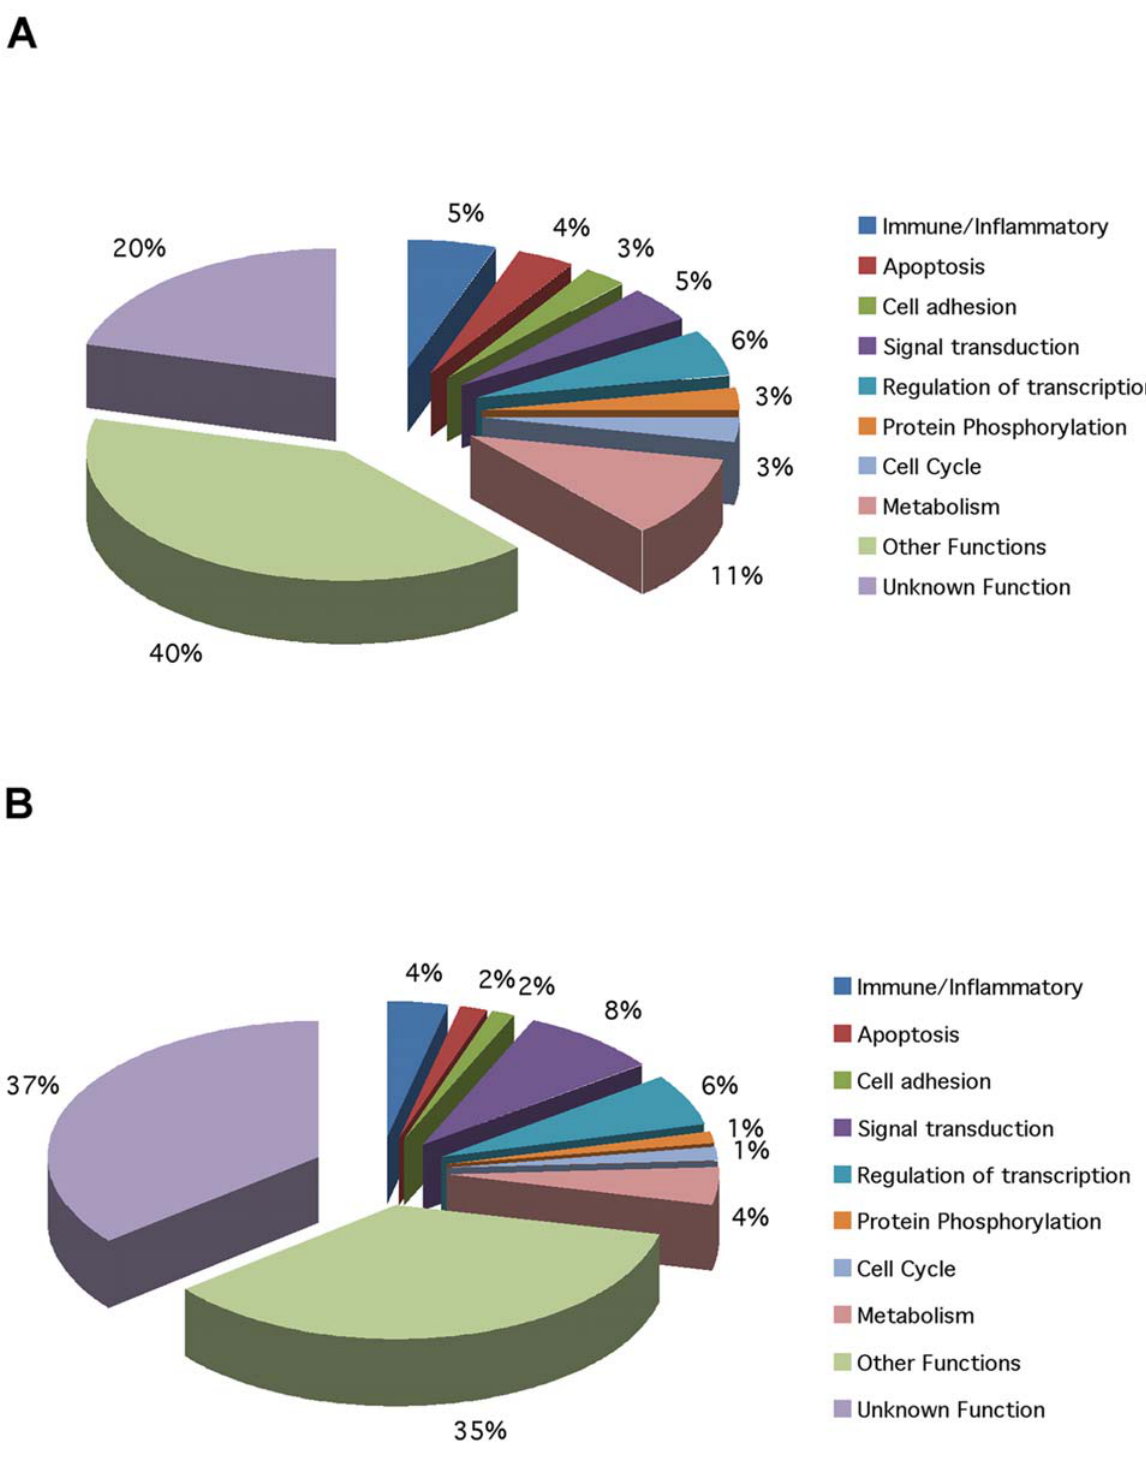
Figure 1. Pie charts showing the Gene Ontology annotations for both Test Sets for Banff 0 vs. Banff 1 (mild CAN). Each slice of the pie chart represents the percentage of genes represented by that functional class. A) Test Set 1 (PBL) for Banff 0 vs. Banff 1; B) Test Set 2 (Whole Blood) for Banff 0 vs. Banff 1. The first key point is that there is no difference in the general groups of differentially expressed, functional genes assigned in an unbiased fashion by analysis using Gene Ontology whether we are interrogating the profiles of PBL or whole blood. The second key point is that there are a number of genes representing different pathways connected to immune/inflammatory and tissue injury mechanisms.